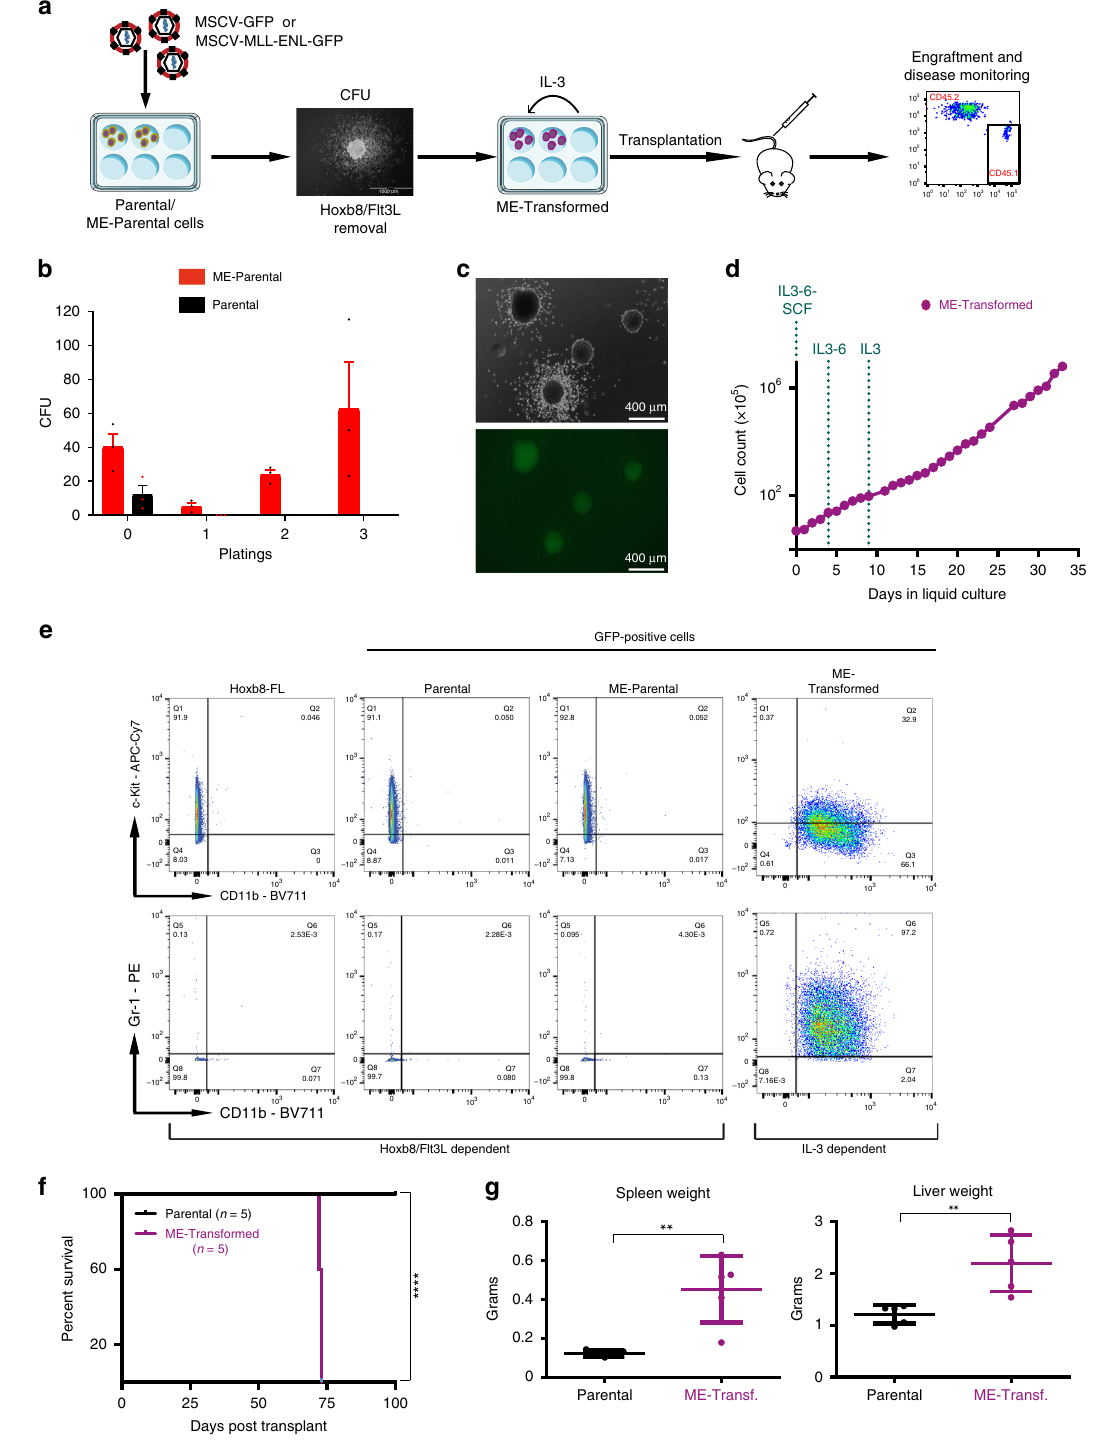
and ME-Transformed cells into 96-well plates for single-cell gene expression analysis (Fig. 2a). Conventional bone marrow progenitors transduced with MLL-ENL (hereafter referred to as MLL-ENL BM) 19 were included as positive controls. Single Parental and ME-Parental cells were processed for scRNA-seq using the Smart-Seq2 protocol 20 . ME-Transformed and MLL- ENL BM cells cultured in the presence of IL-3 were similarly pro fi led.